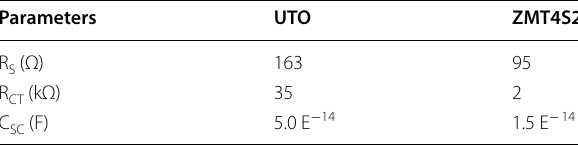
Table 4 EIS fitting parameter values of UTO and ZMT4S2